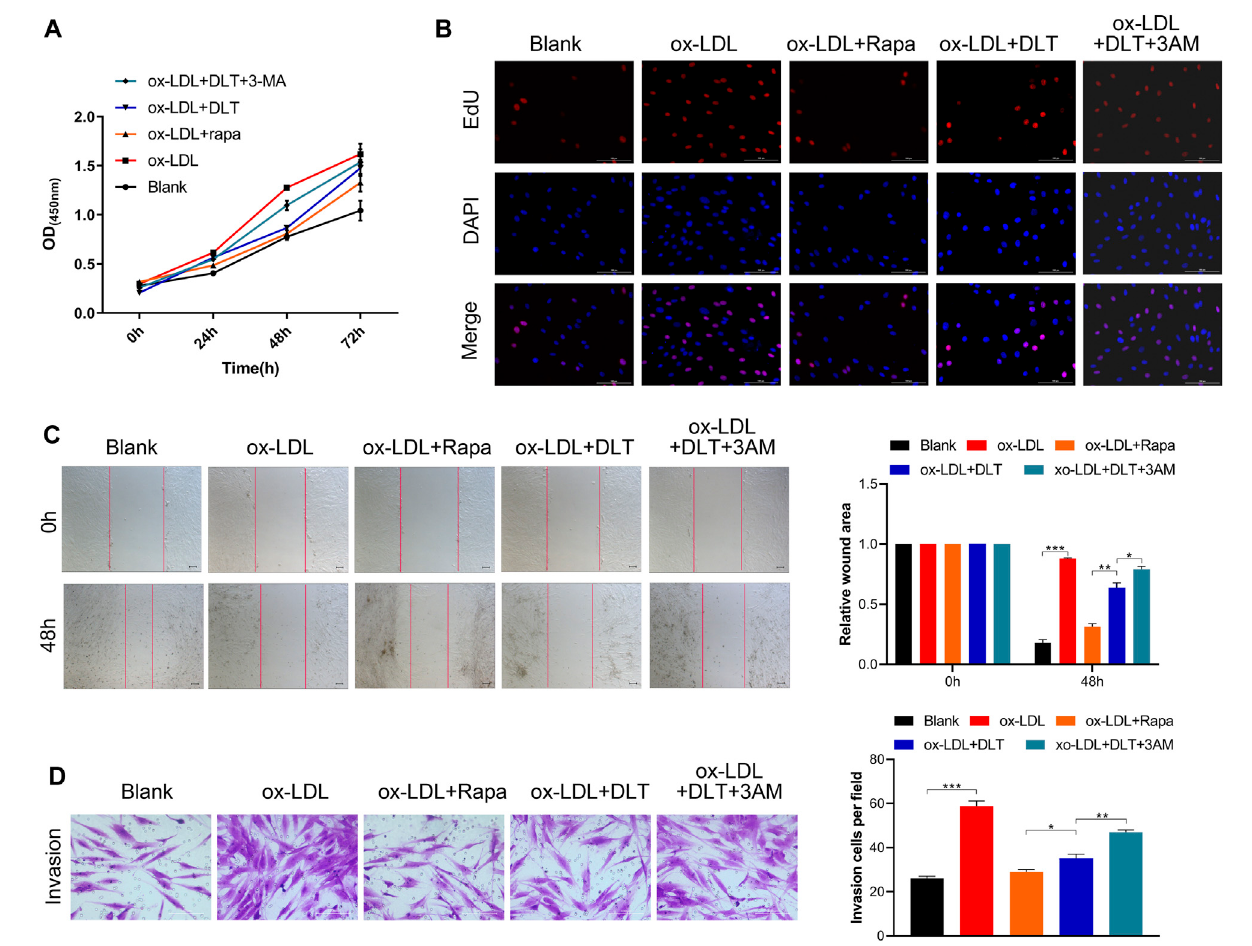
FIGURE 5 | mTOR pathway agonist reverses the effect of DLT. (A, B) CCK8 and EDU assay were used to evaluate the proliferation of DLT and mTOR pathway agonisteffectsintheASmodel. (C,D) ThewoundhealingandtranswellshowedthatthemTORpathwayagonistcouldincreasetheDLT-inducedmigrationintheAScell model (* p < 0.05, ** p < 0.01, *** p <